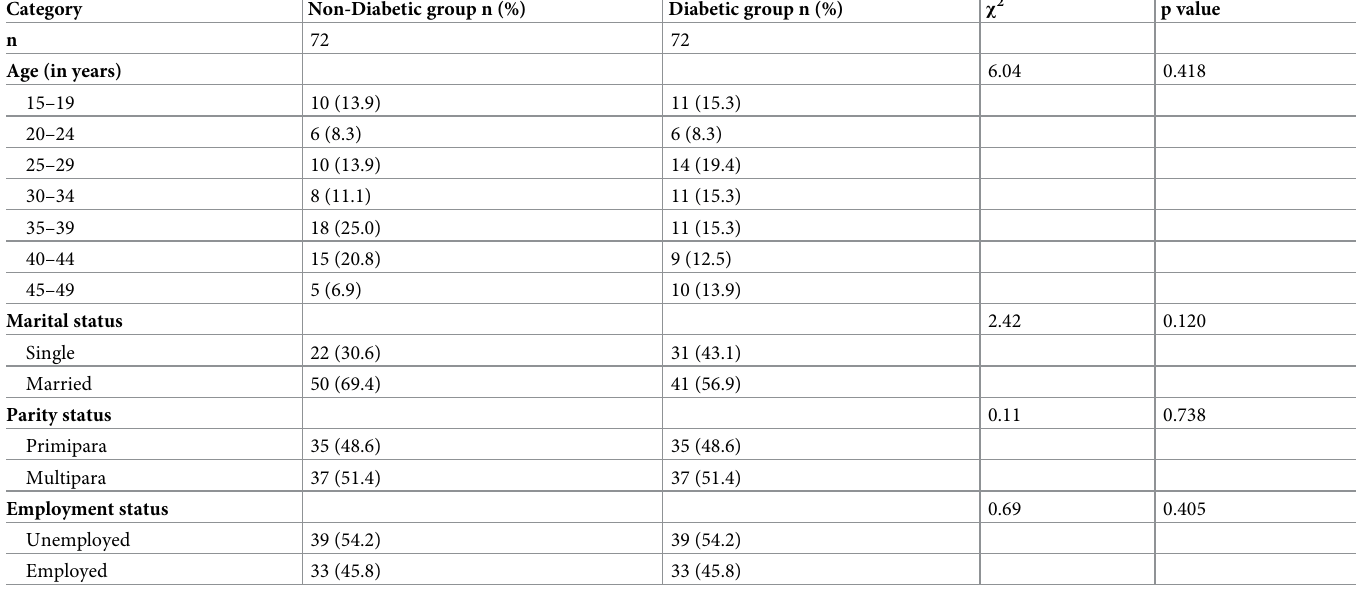
Table 1. Background characteristics of the participants N =